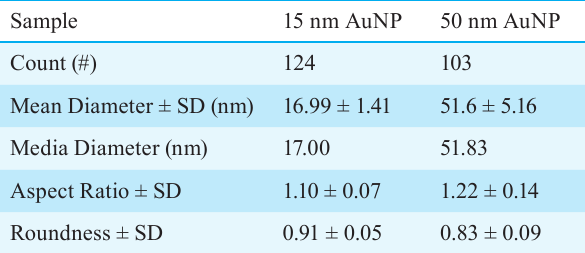
Table 1 TEM image analysis of the representative AuNP sam- ples.